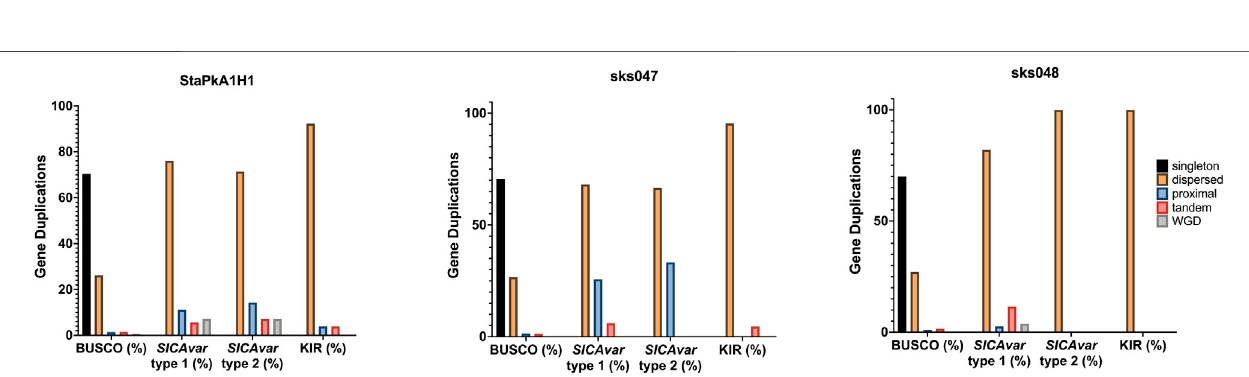
FIGURE 3 | Assembly-based structural variation, size 50 – 10,000 bp, of StAPkA1H1, sks047, and sks048 draft genomes against the PKNH reference genome (Pain et al., 2008). Nucmer alignment was generated using parameters “— maxmatch − l 100 − c 500 ” with default and Assemblytics parameters (Nattestad and Schatz, 2016). Expansions (green and orange) refer to insertions that occur within repeat or tandem variants, while contractions (purple and brown) refer to deletions in these regions. More variation ispresentinthe tandem variants (brown and orange) ofStAPkA1H1than those ofthedraft clinical isolate genomes, sks047 andsks048. In comparison the clinical isolates show more variation in their repeat sequences with similar insertion and deletions (red and blue) and repeat expansion and contraction (green and purple) signatures.